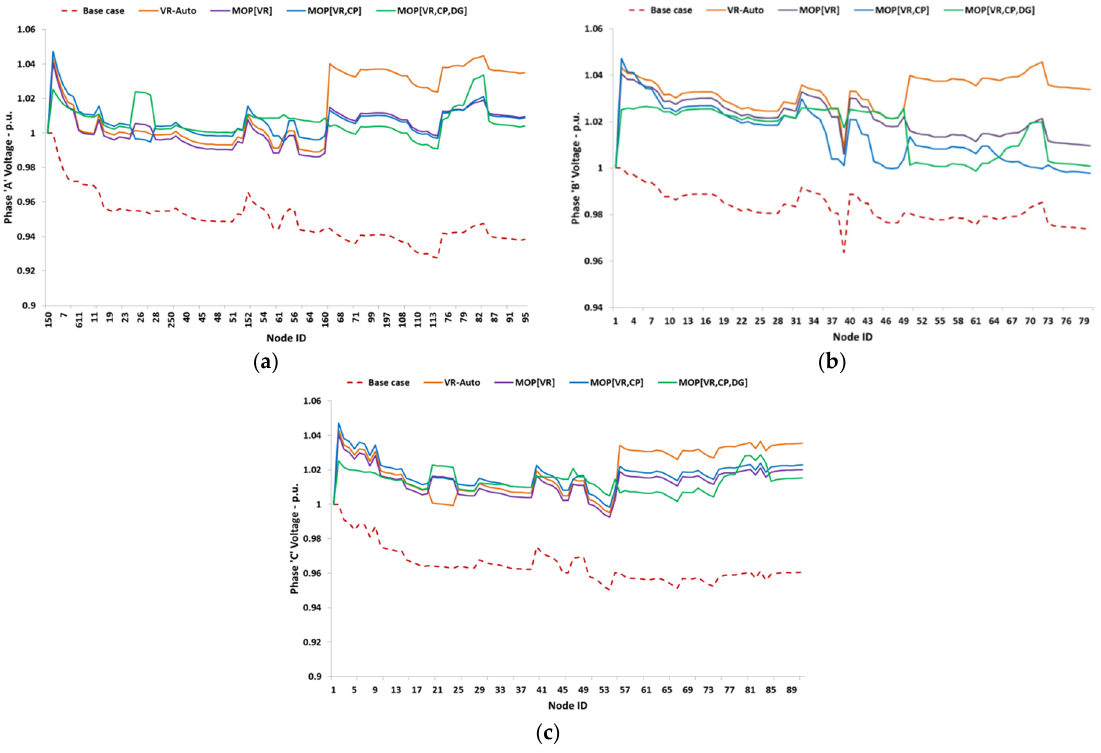
Figure 6. ( a ) Node voltages on phase ‘a’ of IEEE 123 ‐ bus test feeder for different cases of voltage regulation; ( b ) node voltages on phase ‘b’ of IEEE 123 ‐ bus test feeder for different cases of voltage regulation; and ( c ) node voltages on phase ‘c’ of IEEE 123 ‐ bus test feeder for different cases of voltage regulation.